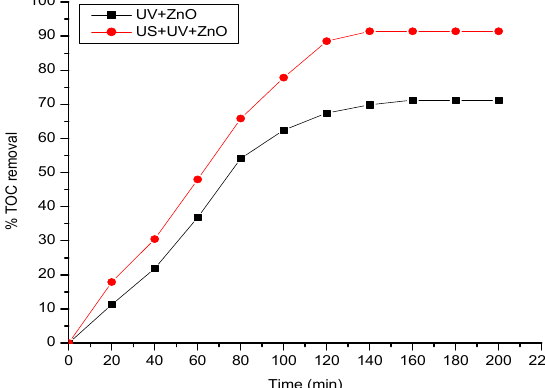
Fig. 3. Effect of pH on textile industry effluent in presence of ZnO nano catalyst (catalyst dose- 1g/L, reaction time 160 min.) Fig.3.Effect of pH ontextile industry effluentin presence of ZnO nano catalyst (catalyst dose-1g/L, reaction time 160 min.)